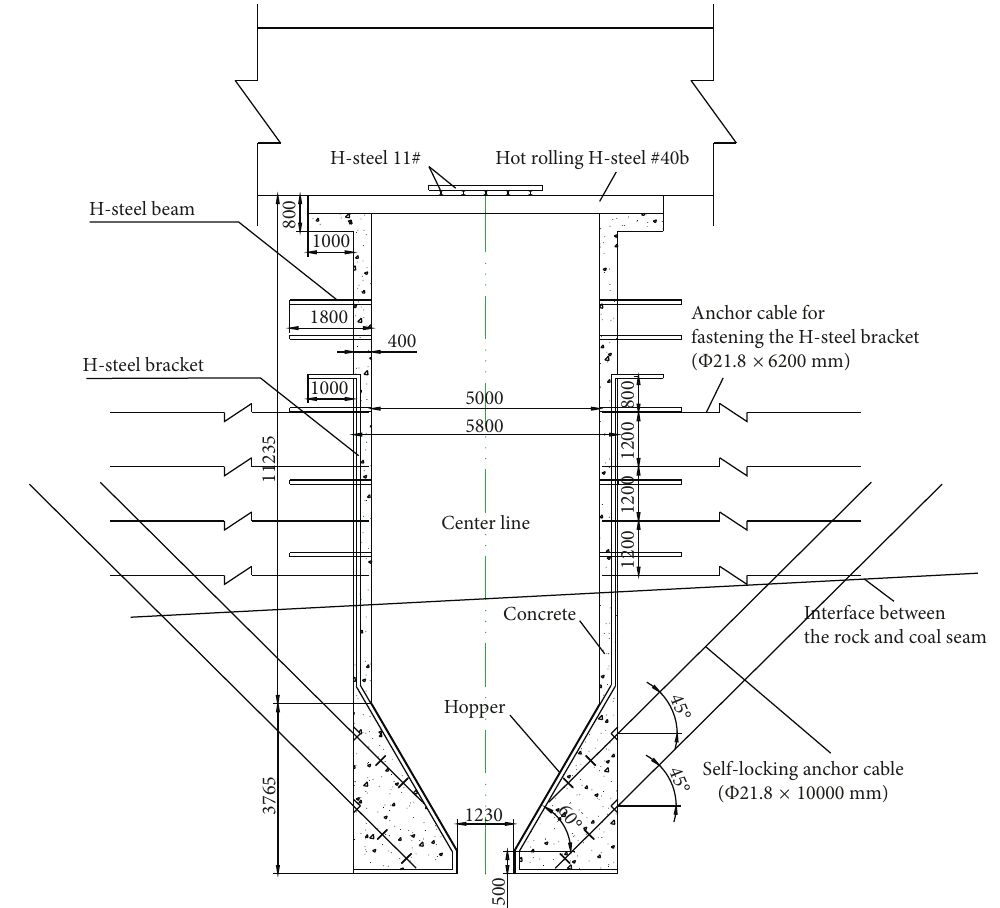
Figure 14: Schematic diagram of the